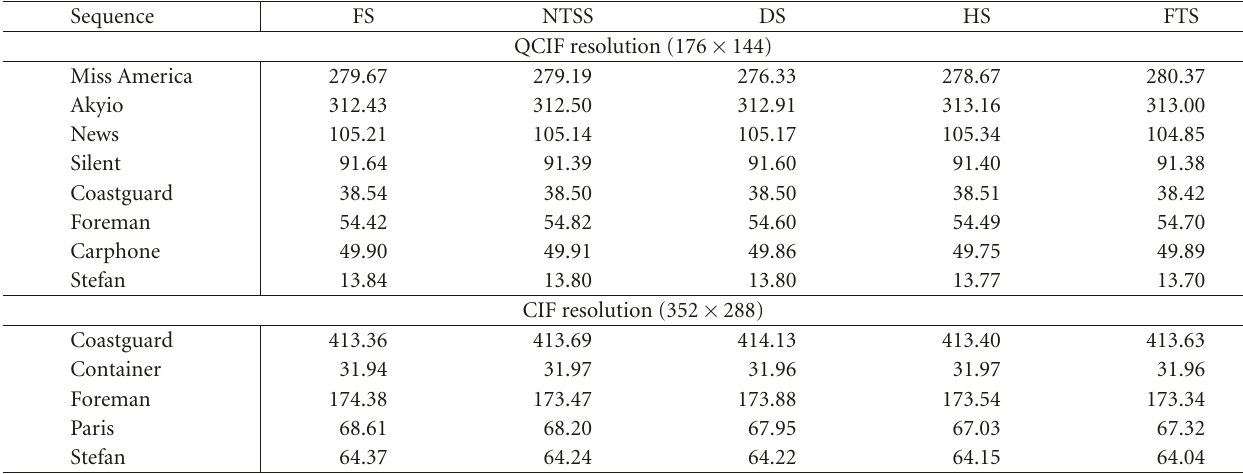
Table 4: Compression ratio (no rate control).